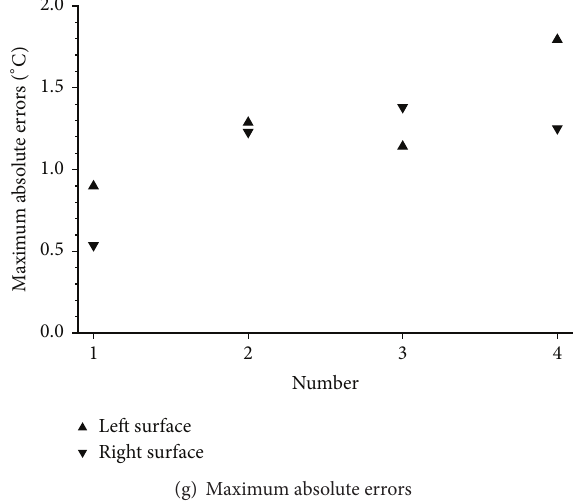
Figure 4: Experimental data of Block 1 wall and calculation